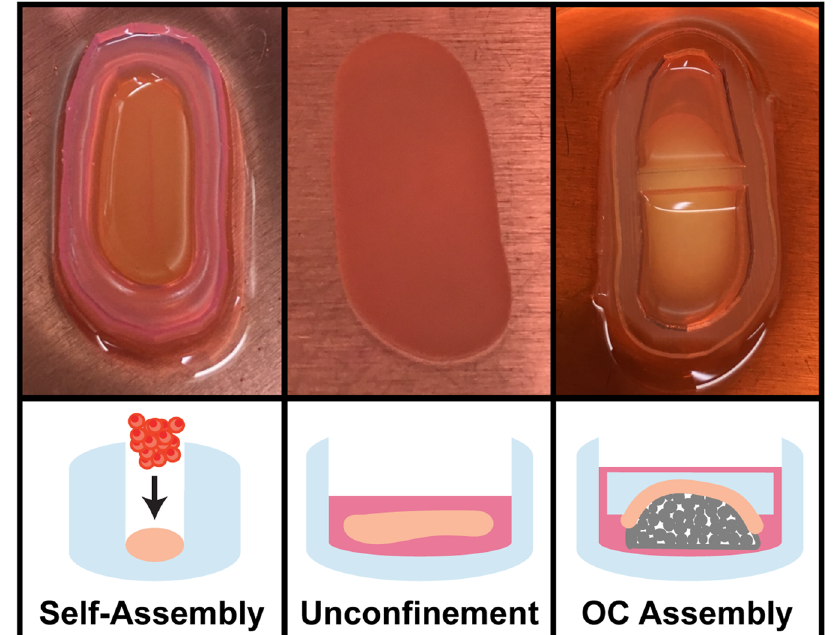
Fig. 8 Osteochondral assembly. Passaged joACs were seeded into fl at-bottom agarose wells (31 × 14 mm) for self-assembly ( t = day 0). At day 2, the neocartilage was uncon fi ned from the wells and cultured as a free- fl oating construct. After OC assembly of the neocartilage and HAp occurred at day 4 or day 10, an agarose cap was placed on top of the osteochondral construct. OC